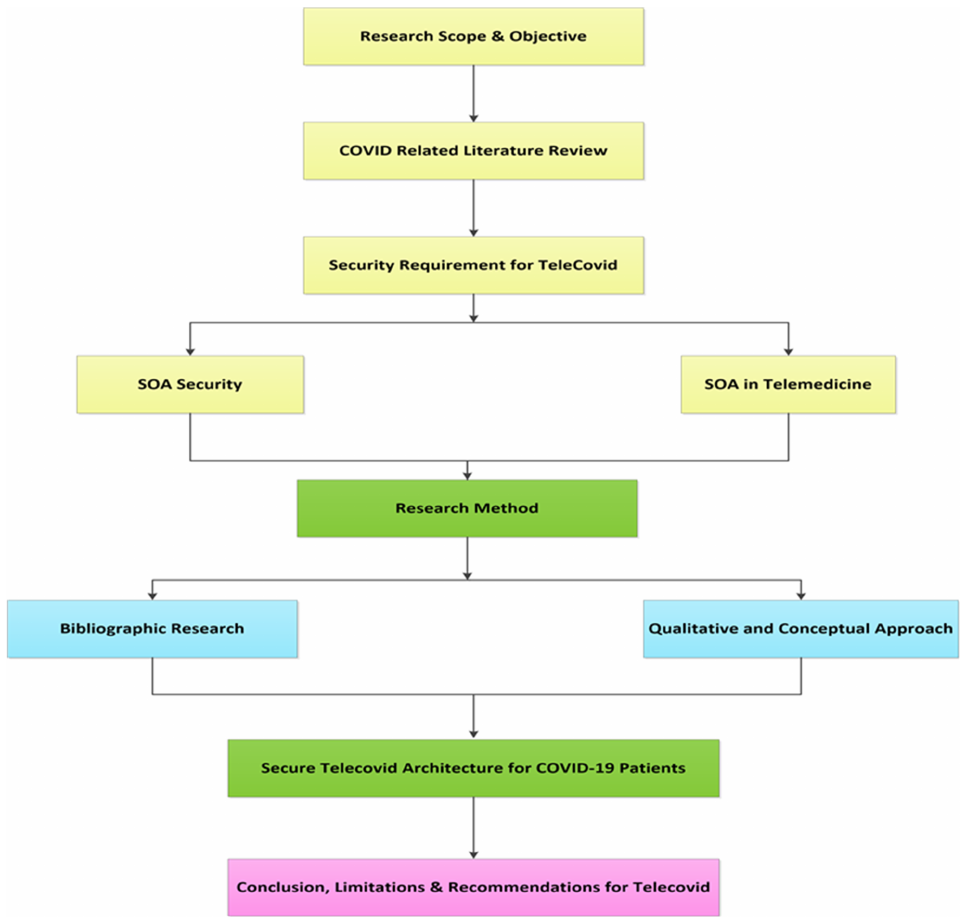
Figure 4. Flow chart of the proposed Tele-COVID